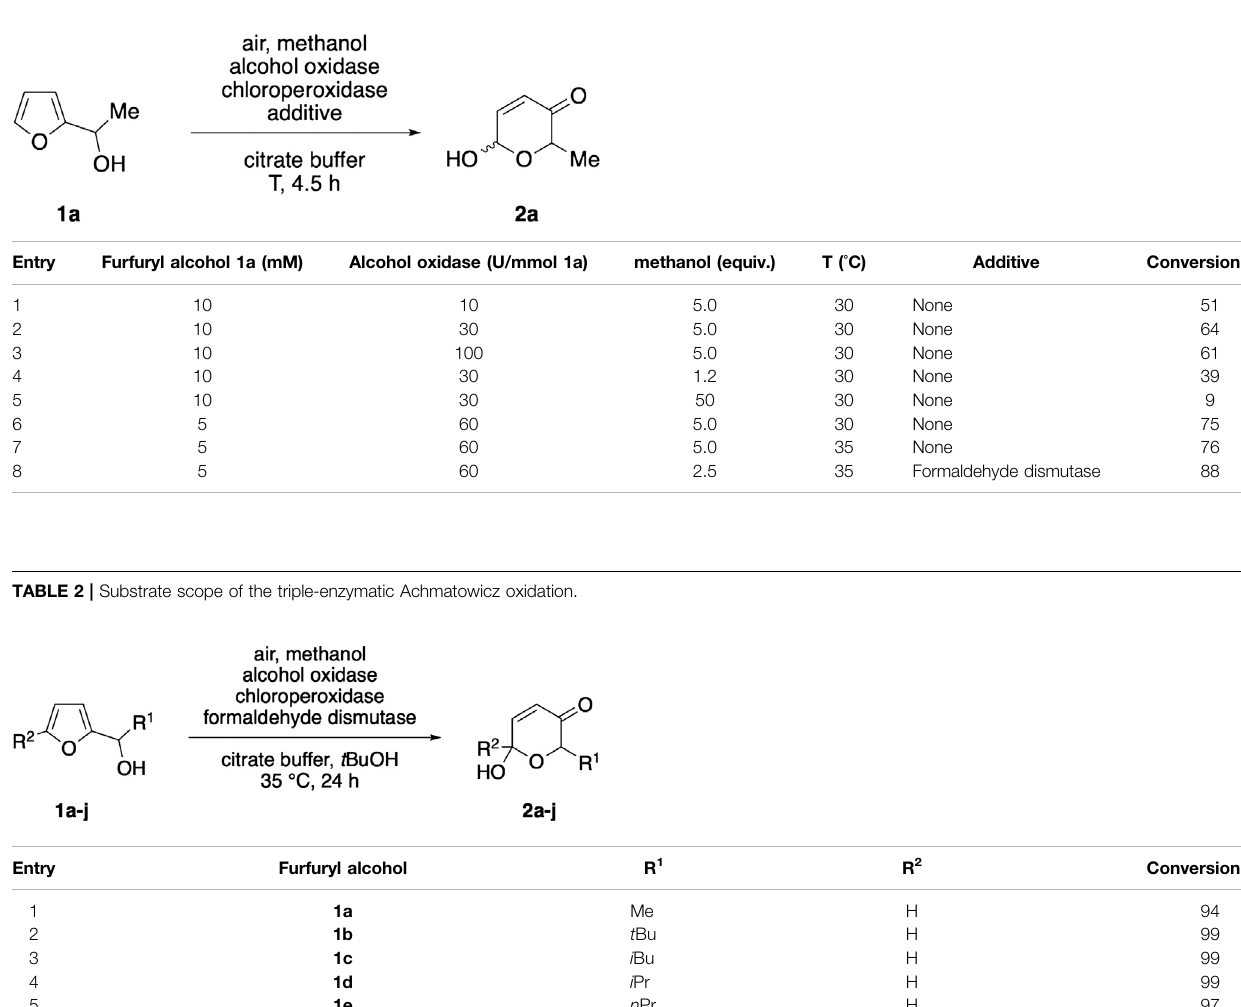
TABLE 1 | Optimization of the oxidase/peroxidase-coupled Achmatowicz rearrangement.